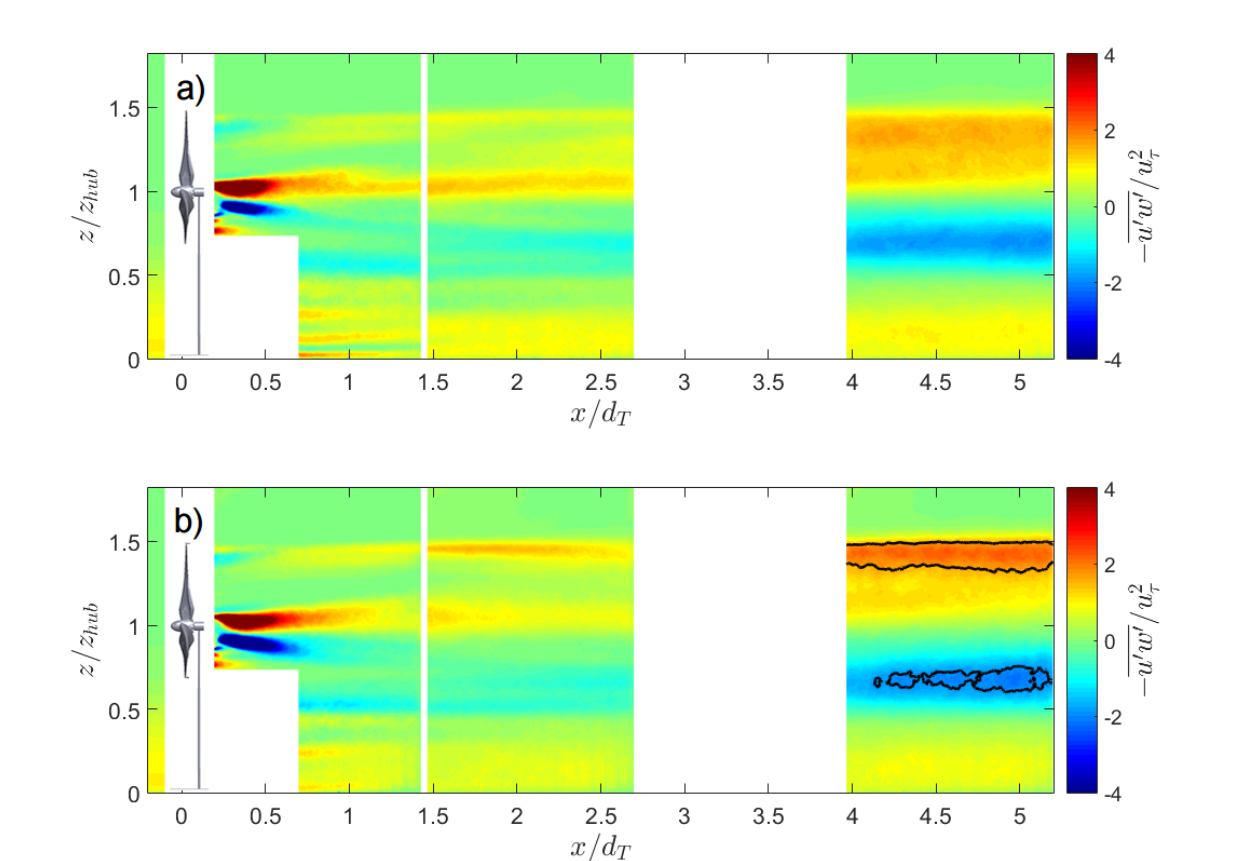
Figure 9. Reynolds stress distribution in the turbine wake: ( a ) standard rotor; ( b ) wingletted. Incoming Reynolds stress is shown upstream of the turbine. Areas in the third panel enclosed in black contours have values higher than the maxima in